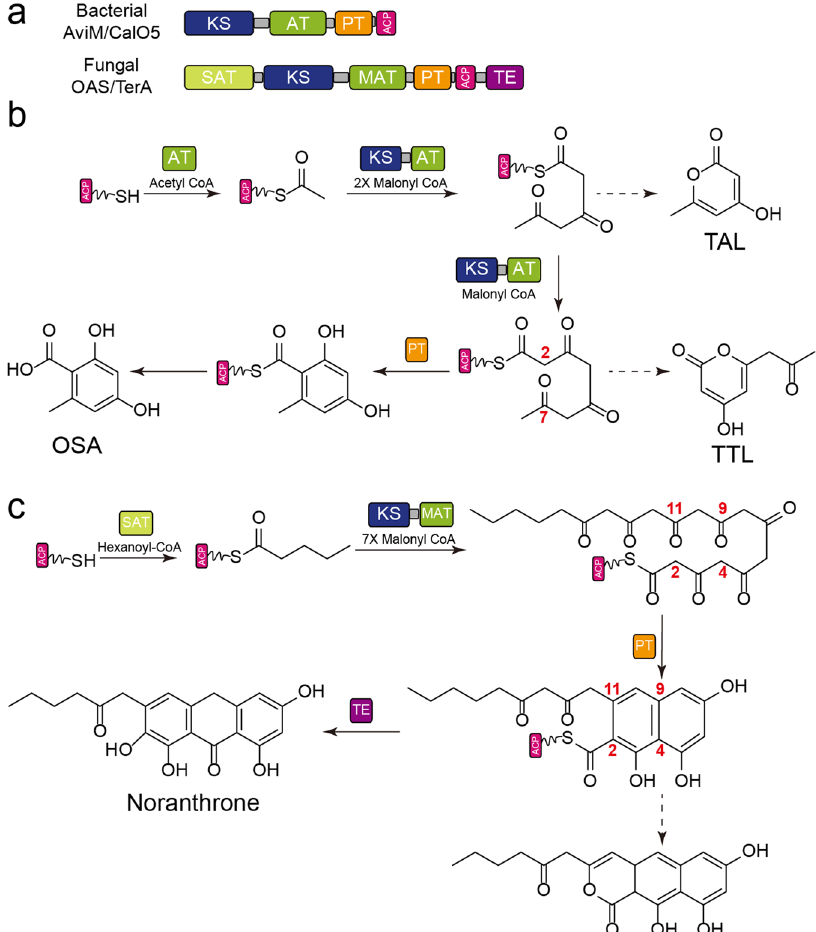
Fig. 1 Biosynthesis reaction of OSA and A fl atoxin. a The domain compositions of bacterial and fungal OSASs. Bacterial OSASs lack the starter-unit acyl transferase (SAT) and the thioesterase (TE) domains. b Biosynthesis of OSA in bacteria. Triacetic acid lactone (TAL) released after two condensation steps and tetraacetic acid lactone (TTL) are generated in the absence of PT due to the spontaneous O – C cyclization. AviM PT catalyzes the C2 – C7 cyclization. c Biosynthesis reaction of A fl atoxin. PksA PT catalyzes the C4 – C9 and C2 – C11